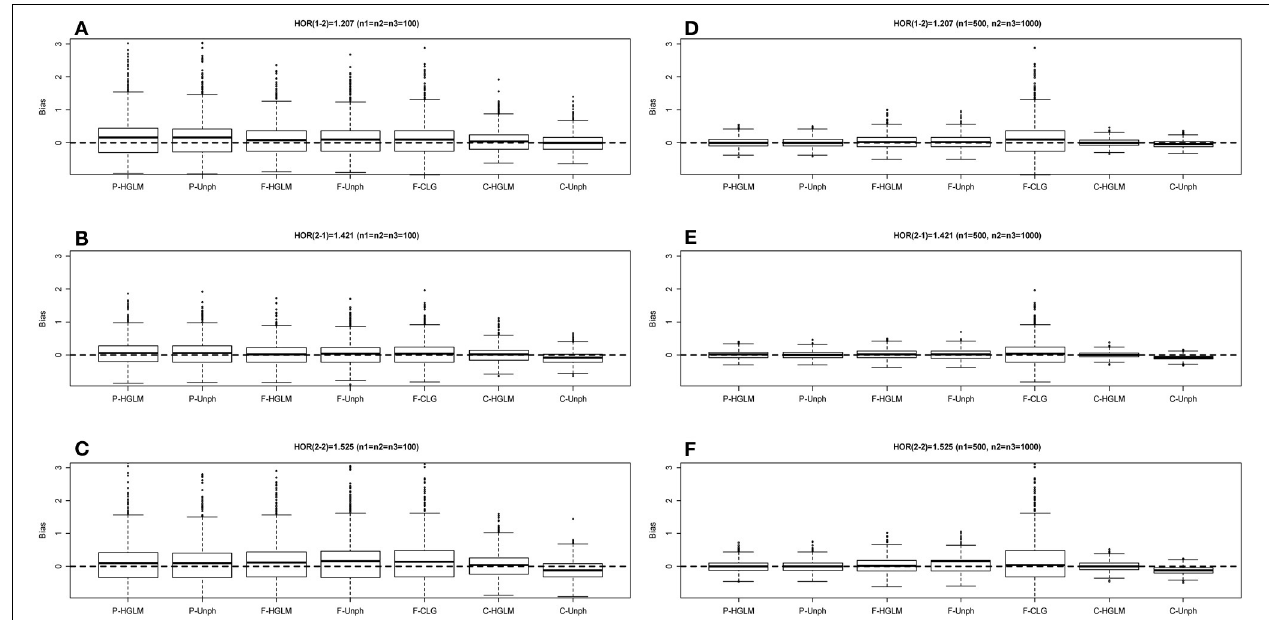
FIGURE 3 | Boxplot of estimate biases (estimate - true HOR) for haplotype odds ratios (HOR) based on mild effect model over 1000 replications. (A–C) Denotes the HOR = 1.207, 1.421, 1.525 for n 1 = n 2 = n 3 = 100 and (D–F) is HOR = 1.207, 1.421, 1.525 for n 1 = 500 , n 2 = n 3 = 1000.